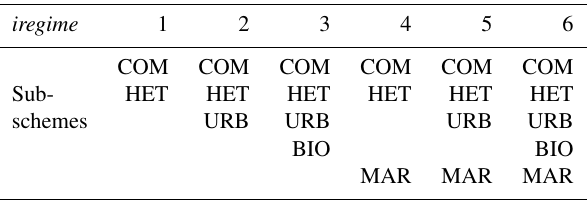
Figure 1. The framework of the CBM-Z gas-phase chemistry mod- ule. The functions in the yellow font represent the inner function of IntegrateChemistry . Table 1. The possible values of iregime and the combination of chemical